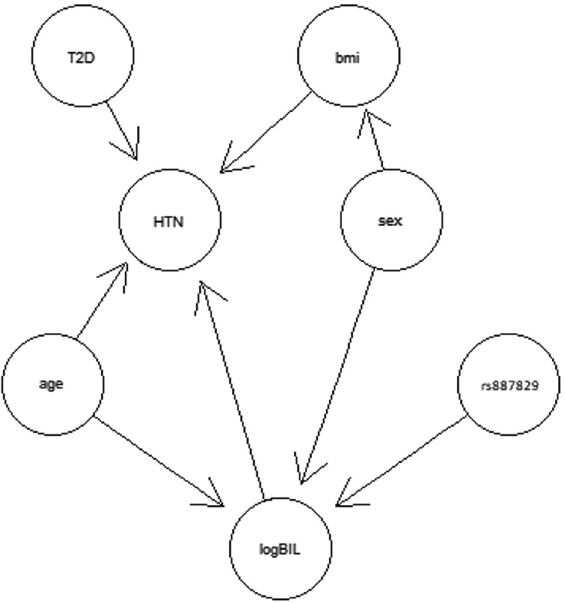
Fig. 3 Additive Bayesian network (ABN) plot for African ancestry. The dosage of the genetic variant rs887829 indirectly affects hypertension status via bilirubin levels using 20,000 heuristic